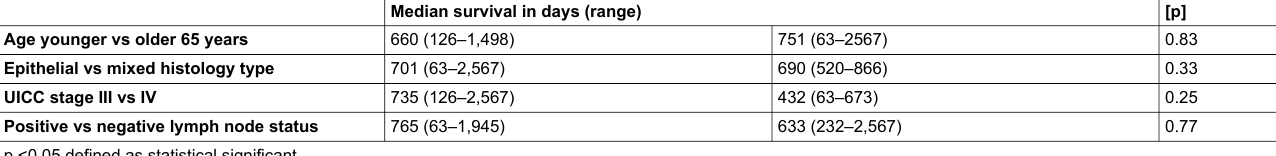
Table 5: Median survival rates of patients in the trimodal therapy group (n = 21) regarding age, type of histology, UICC stage and lymph node